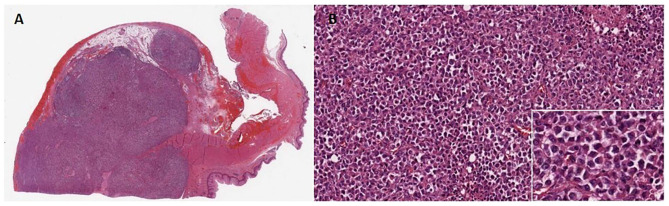
(A) Microscopic findings of the tumor at 5× magnification. Anaplastic large cells showing solid growth pattern and poorly cohesive growth. (B) Higher magnification (20×) view of the solid growth area. White box underlines at 100× magnification tumor cells exhibiting large nuclei with conspicuous nucleoli and eosinophilic “rhabdoid” cytoplasmic inclusions, while the nucleus is displaced eccentrically by the cytoplasmic inclusion body.